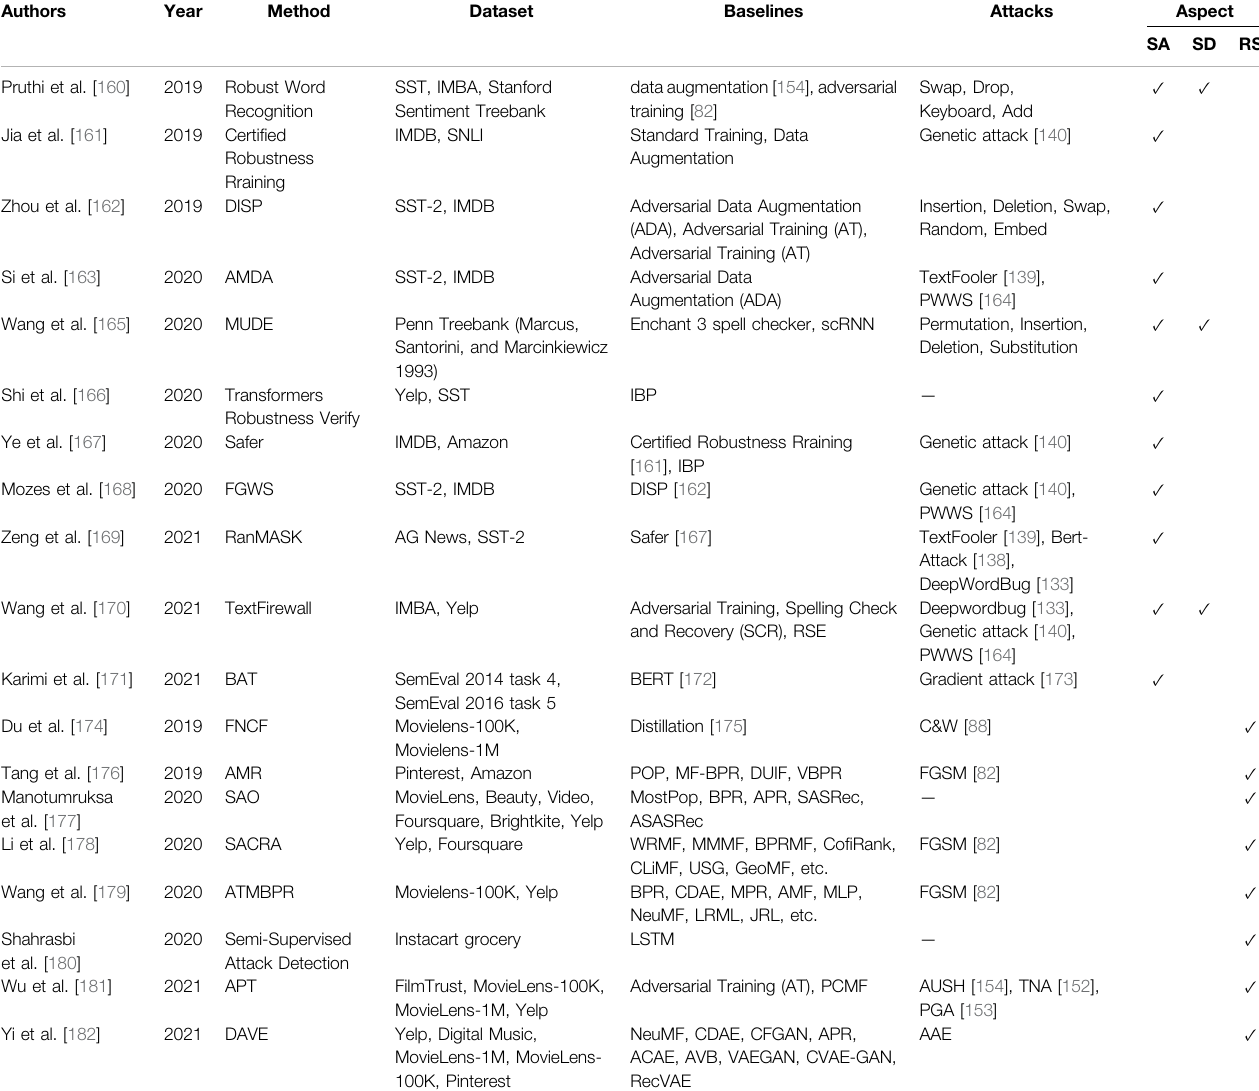
TABLE 5 | Defend against to adversarial examples in social